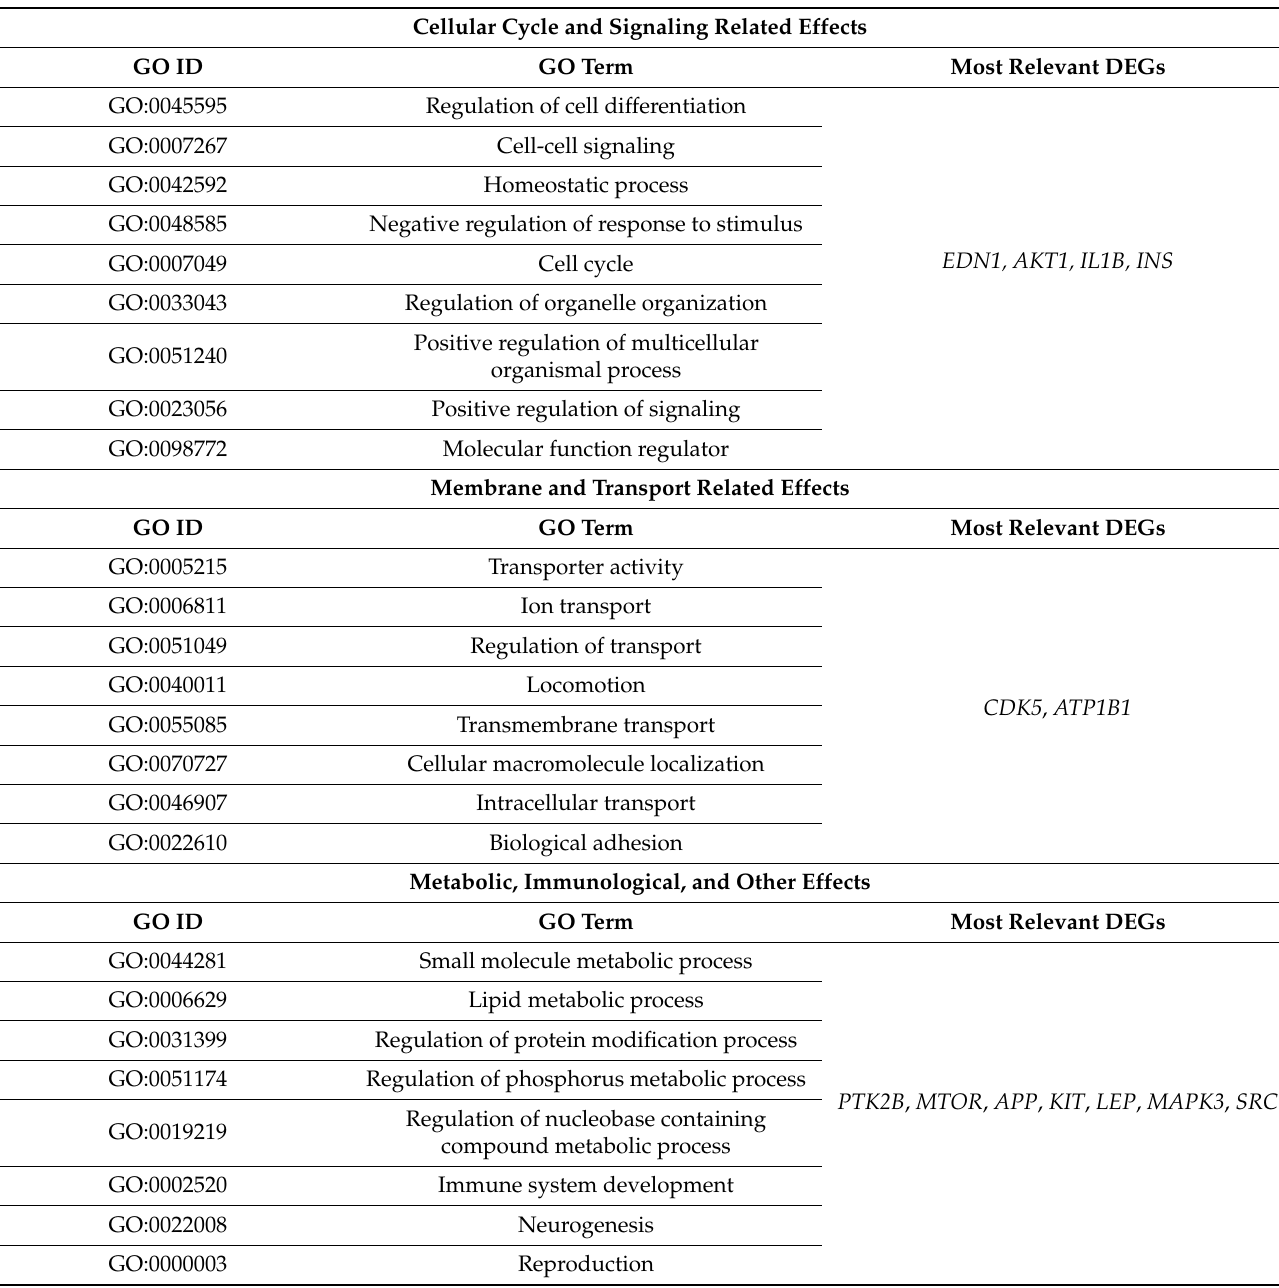
Table 3. Categorized lists of the top 25 common dysregulated GO terms among serous ovarian tumors reclassified by biological functions and the most relevant corresponding DEGs in each